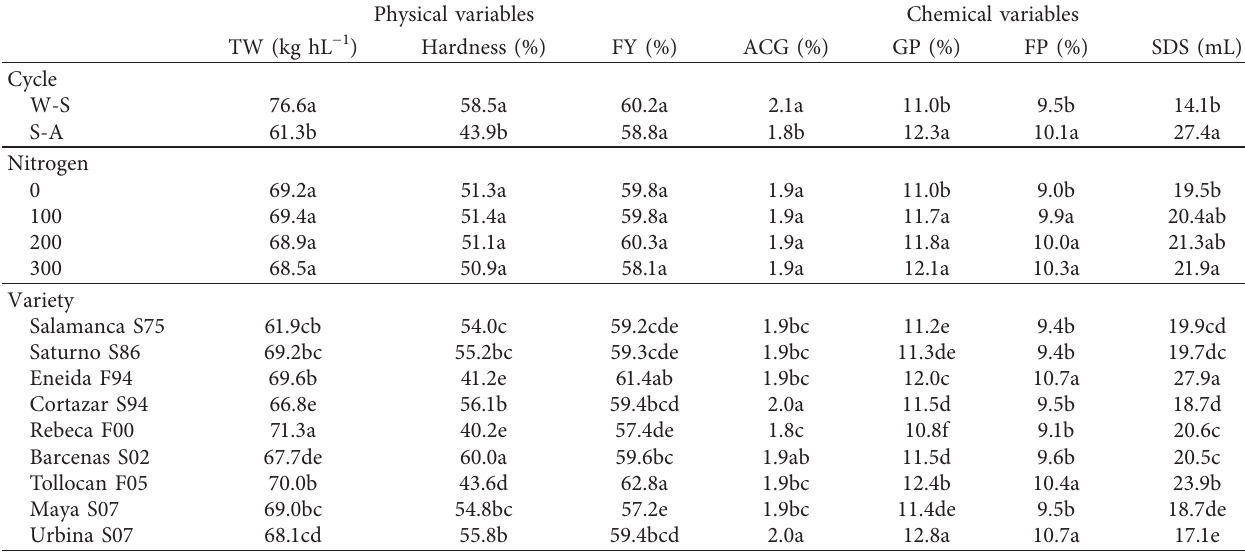
Table 2: Mean values for test weight (TW), hardness, flour yield (FY), ash content in grain (ACG), grain protein (GP), flour protein (FP), and sedimentation volume (SDS) for nine wheat cultivars under 4 nitrogen fertilization rates in Toluca,